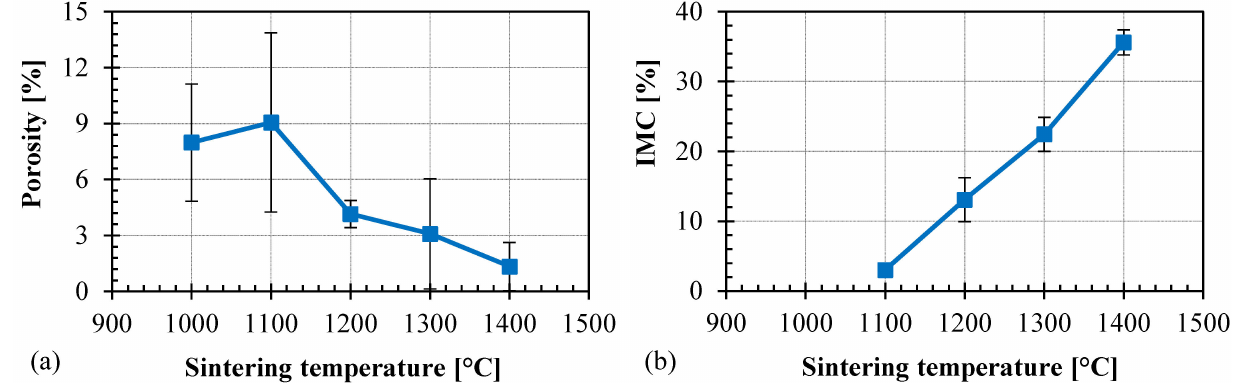
Figure 5. ( a ) Porosities and ( b ) IMC of 75 W composites sintered at different temperatures. (Note: for the sintering performed at 1000 ◦ C, the amount of IMC could not be determined using image analysis as it was very minimal. However, it must be noted that even at 1000 ◦ C, there will be generation of IMC, but its amount is not high enough to be captured by image analysis).